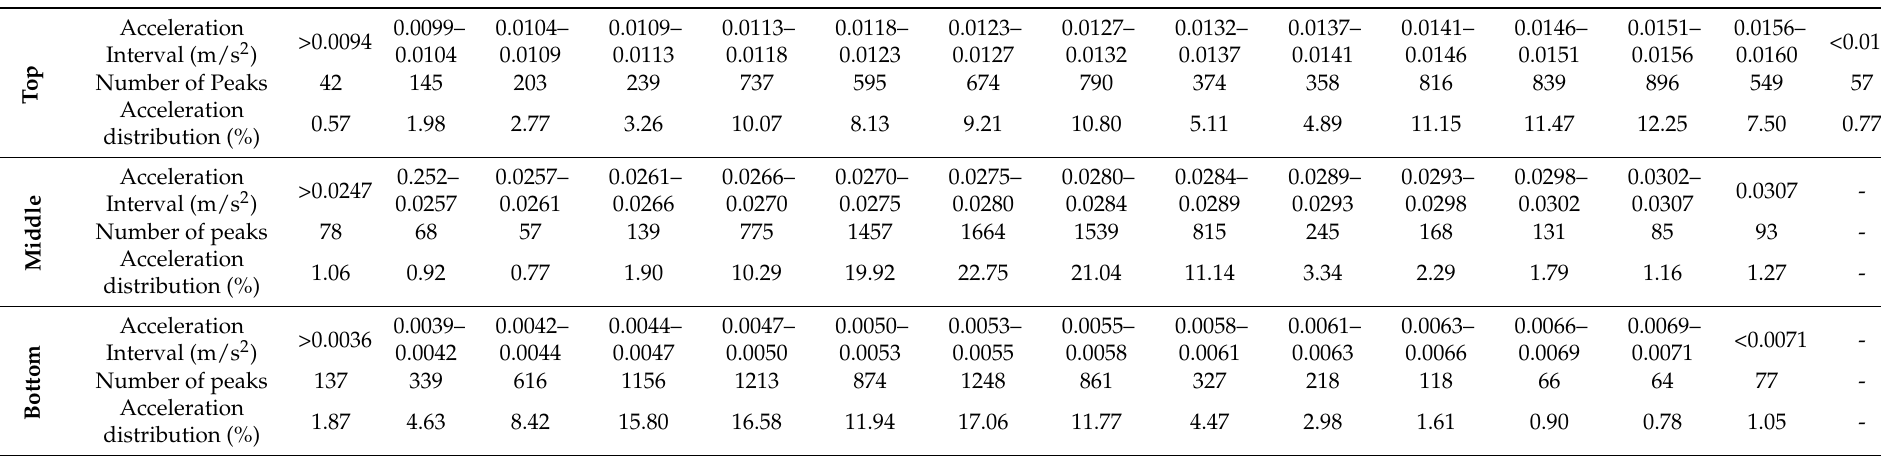
Table 1. Vibration accelerations data during simulated